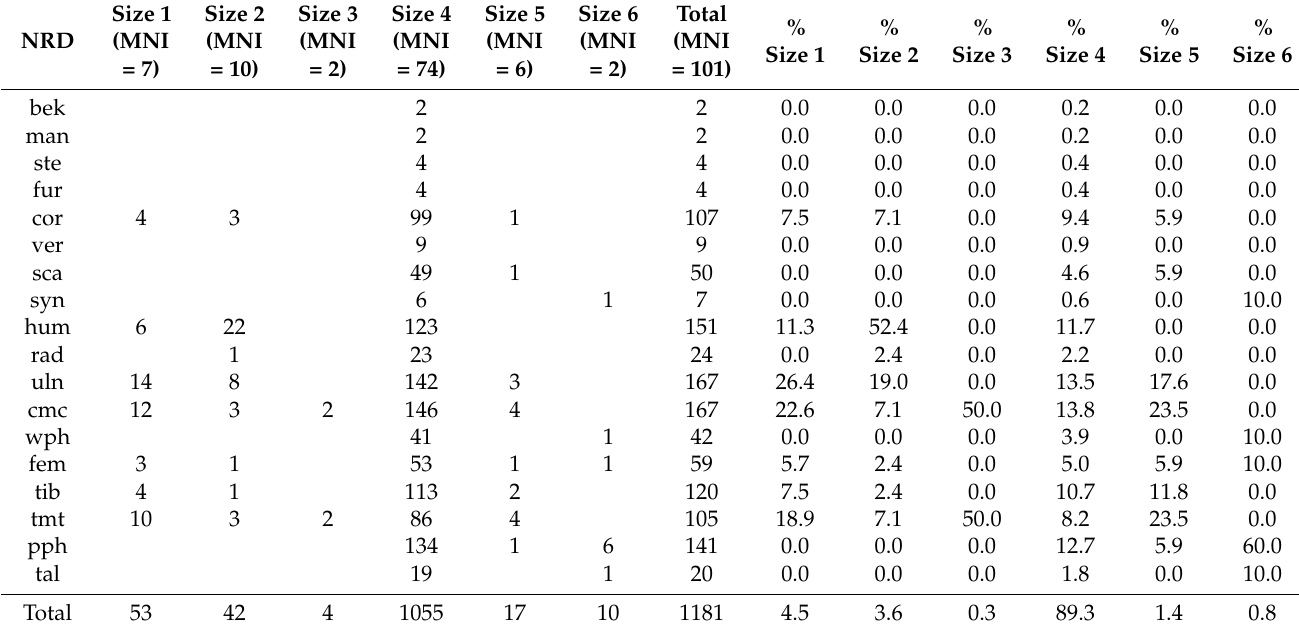
Table A2. Representation of Grotte Vaufrey layer VIII remains by size. The classification of remains by size has been evaluated considering the bird’s weight (see Section 2). NRD: number of remains determined. Bek: beak; man: mandible; ste: sternum; fur: furcula; cor: coracoid; ver: vertebra; sca: scapula; syn: synsacrum; hum: humerus; rad: radius; uln: ulna; cmc: carpometacarpus; whp: wing phalanx; fem: femur; tib: tibiotarsus; tmt: tarsometatarsus; pph: posterior phalanx (talon excluded); tal: talon.